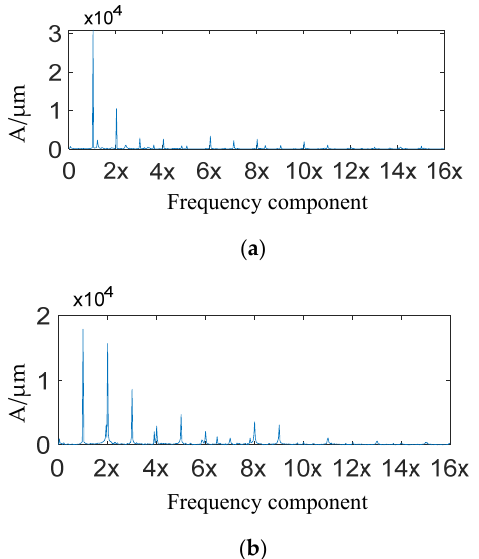
Figure 22. Spectrum diagram of rubbing fault. ( a ) Slight rubbing ( b ) Serious rubbing. The 1600 Hz sampling frequency and 128 window width is taken to perform the GLCT, SET and RSECT for the signal of slight rubbing and serious rubbing, respectively. The corresponding time–frequency distribution of the three methods are shown in Figures 23–25.